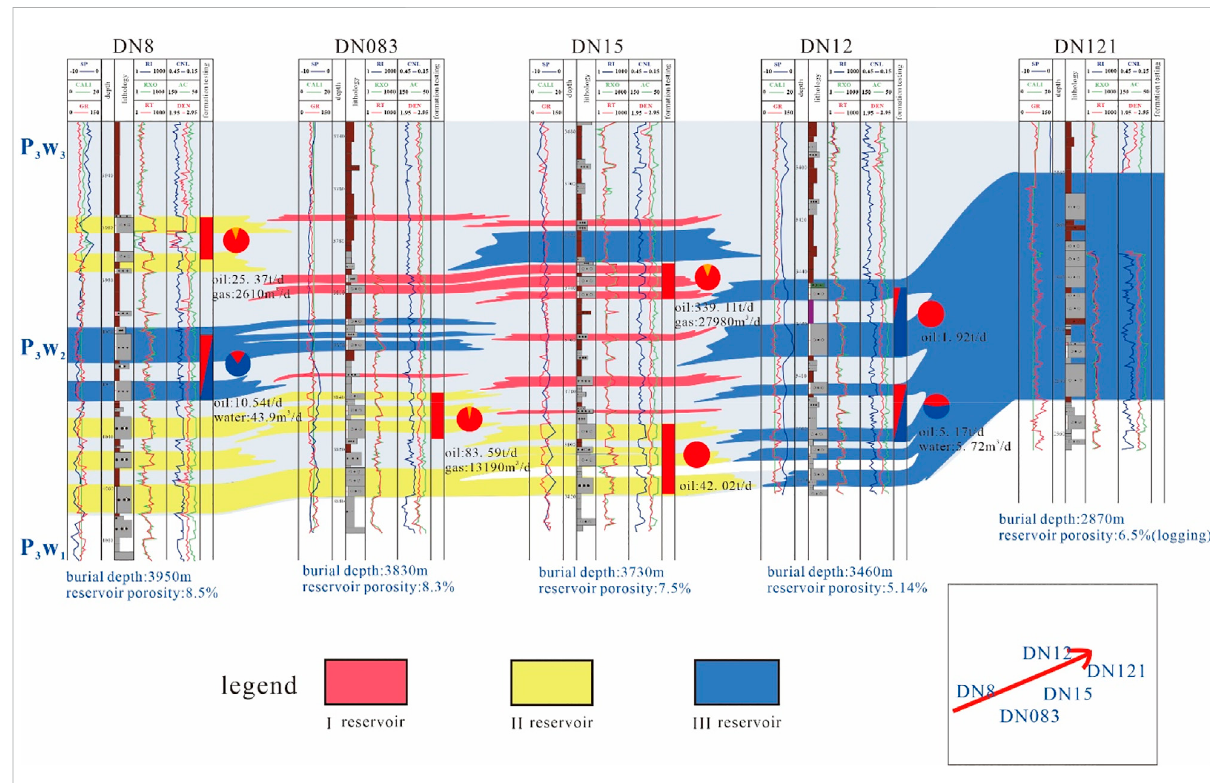
FIGURE 9 Prediction on reservoir distribution on the Dinan 8 well – Dinan 15 well – Dinan 121 well pro fi